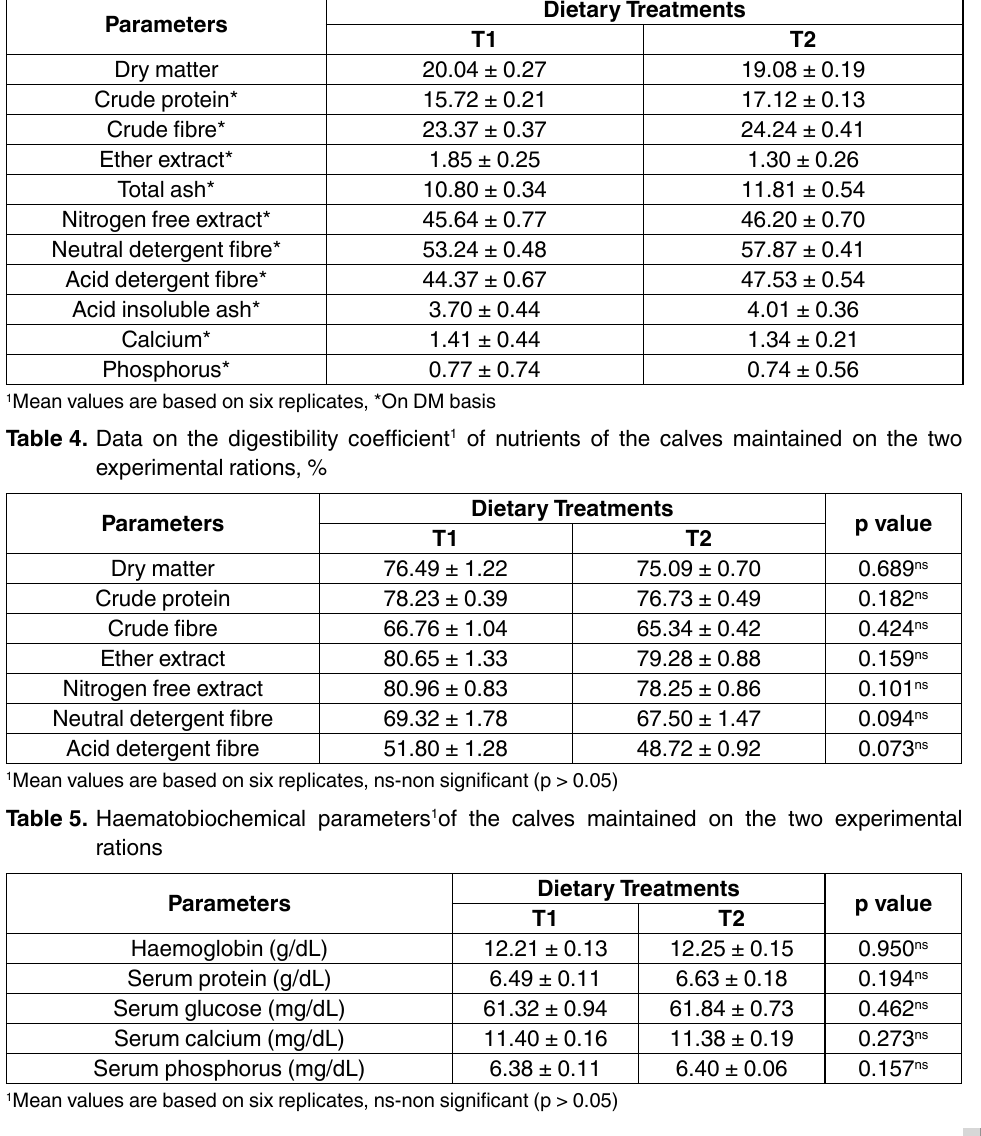
table 3. Chemical composition 1 of dung of the calves maintained on two experimental rations, % Parameters